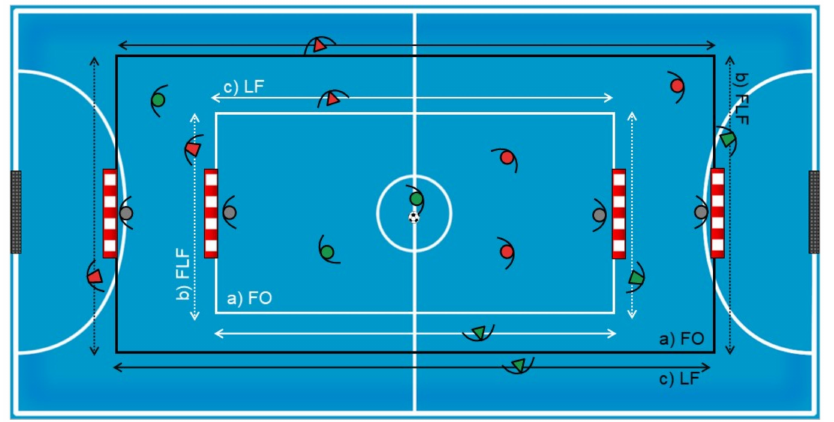
Figure 1. 3vs3 and 2vs2 experimental conditions. ( a ) FO: Floaters Off; ( b ) FLF: Final Line Floaters; ( c ) LF: Lateral